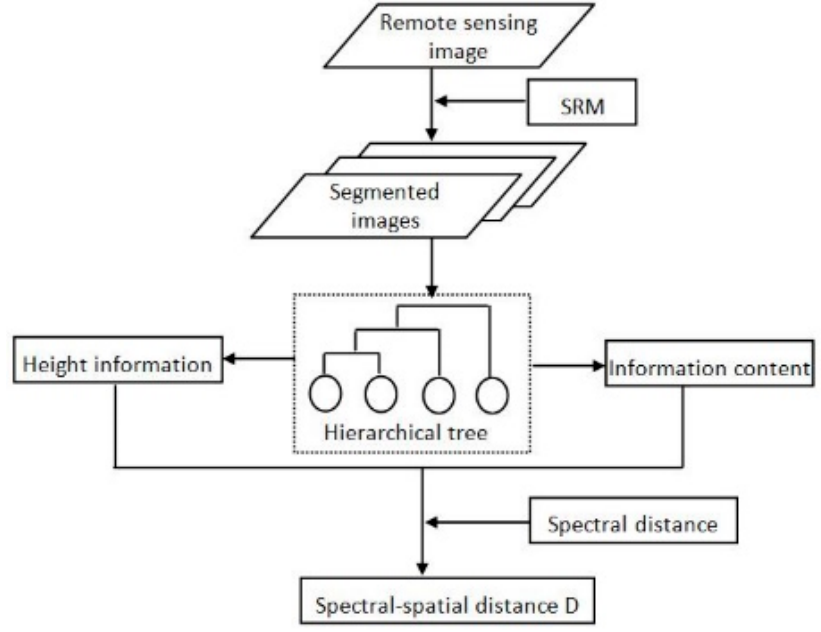
Figure 2. Flowchart of the proposed comprehensive spectral-spatial distance D.